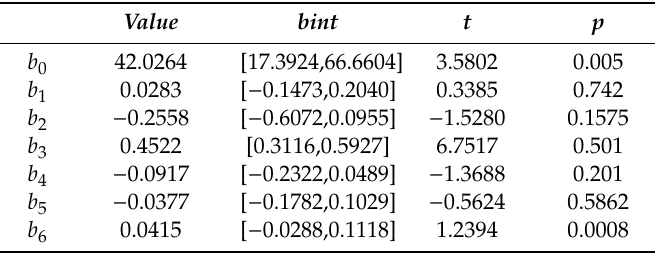
Table 3. Regression coe ffi cient interval.